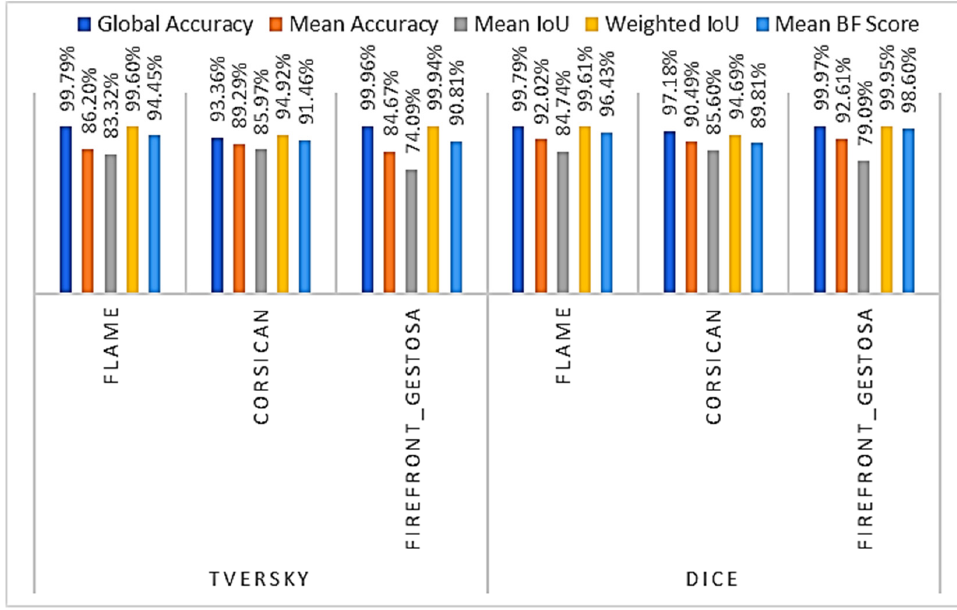
Figure 11. The overall metrics, over the three sets of data (FLAME, Corsican, and Firefront_Gestosa), were gathered using Tversky and Dice loss functions with Deeplabv3+ with ResNet-50 as a backbone.